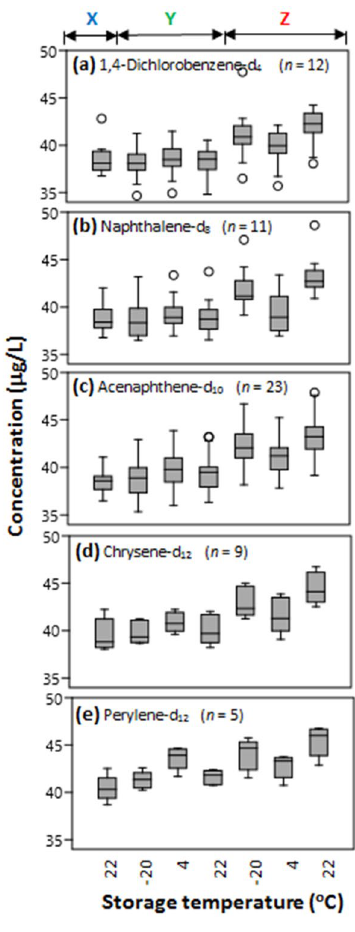
Figure 4. Boxplots of recoveries of 60 SVOCs in solution (each 40 μg/mL; benzidine and 3,3 ′ -dichlorobenzidine at 80 μg/mL) as in Fig. 3 but broken down to values as measured by the respective internal standards ( a – e ) added on the day of preparation and analyzed by GC/MS immediately ( X ) and 36 days thereafter ( Y ), and when internal standards were added after 36 days of storage ( Z ). The number of SVOCs studied in each of the five cases (a-e) is given by the value of n in parenthesis. Conditions are color coded as in Fig.